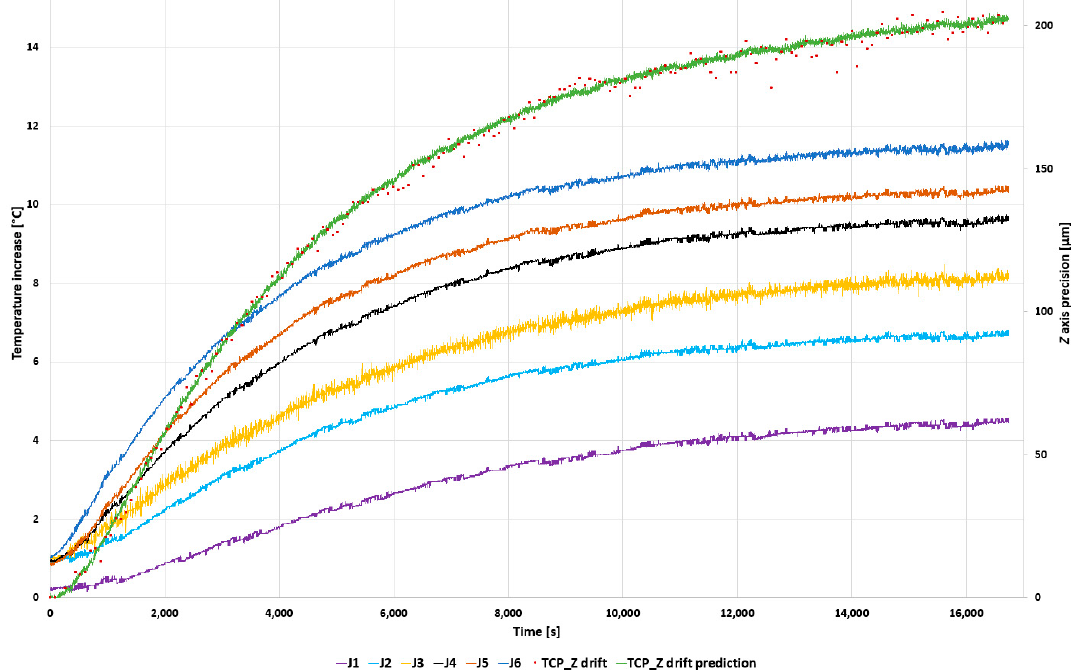
Figure 10. Target 5, working speed TCP Z Drift measurement and prediction. Data recorded during the initial measurement: purple—joint 1 temperature, light blue—joint 2 temperature, yellow—joint 3 temperature, black—joint 4 temperature, orange—joint 5 temperature, dark blue—joint 6 temperature, red dots express the uncompensated TCP Z-axis drift, green dots—TCP Z drift prediction based on MatLab regression learner.